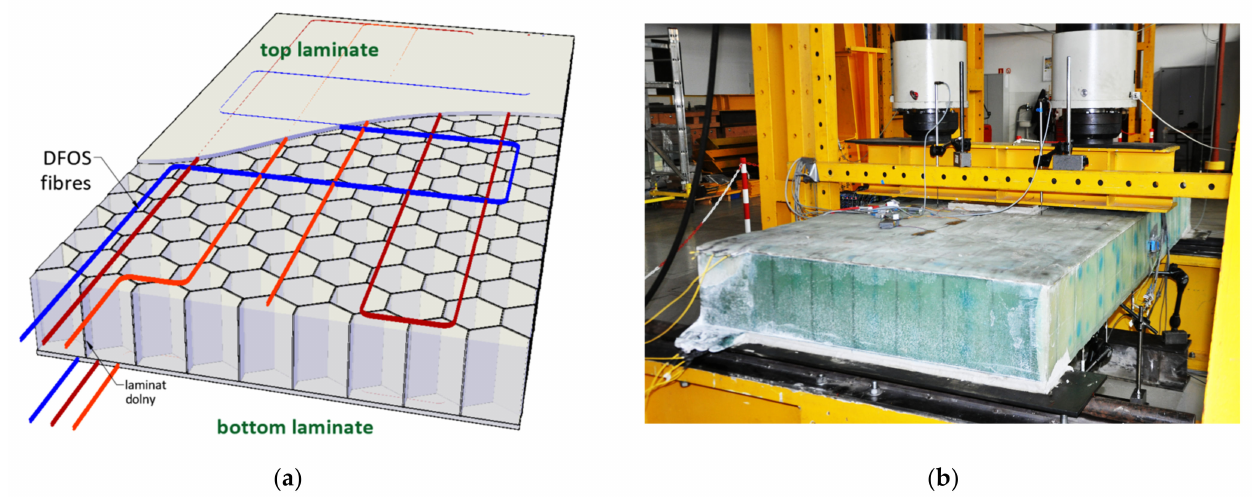
Figure 31. Idea of 3DSensor by integration of optical fibres during infusion of composite bridge panel: ( a ) designed spatial visualization; ( b ) ready panel before laboratory